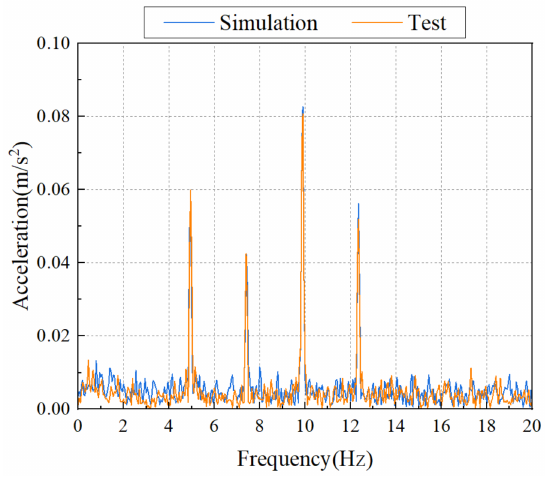
Figure 11. Seat cushion vibration response for crushing condition. Table 3. Key frequency points and key frequency point amplitudes for seat cushion simulation and test.